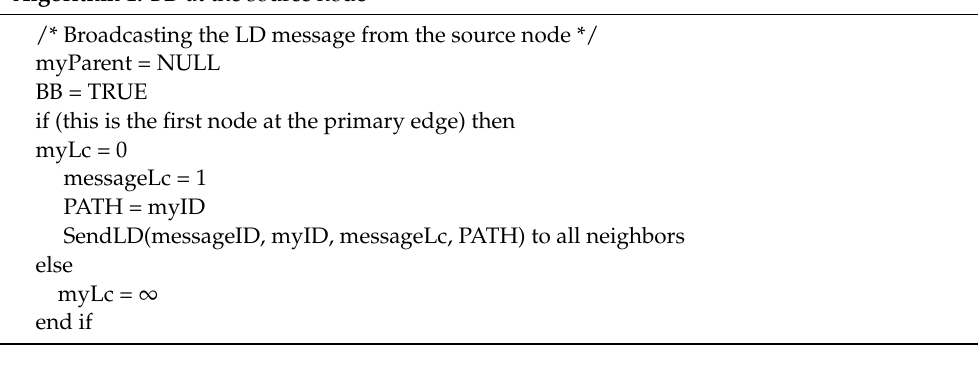
Algorithm 1: BD at the source node